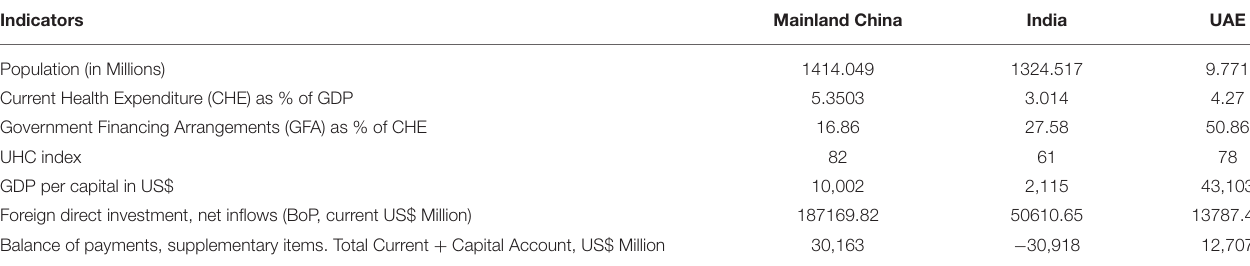
TABLE 1 | A summary of healthcare sector and economic indicators in Mainland China, India, and the UAE [as of 2019 (source: www.who.org)].